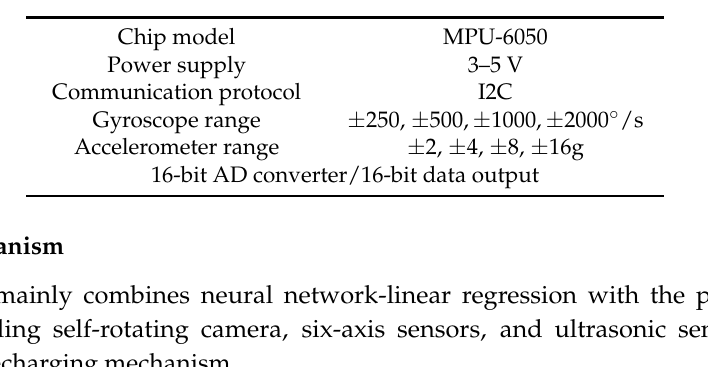
Table 2. Specifications of MPU-6050 six-axis sensor.